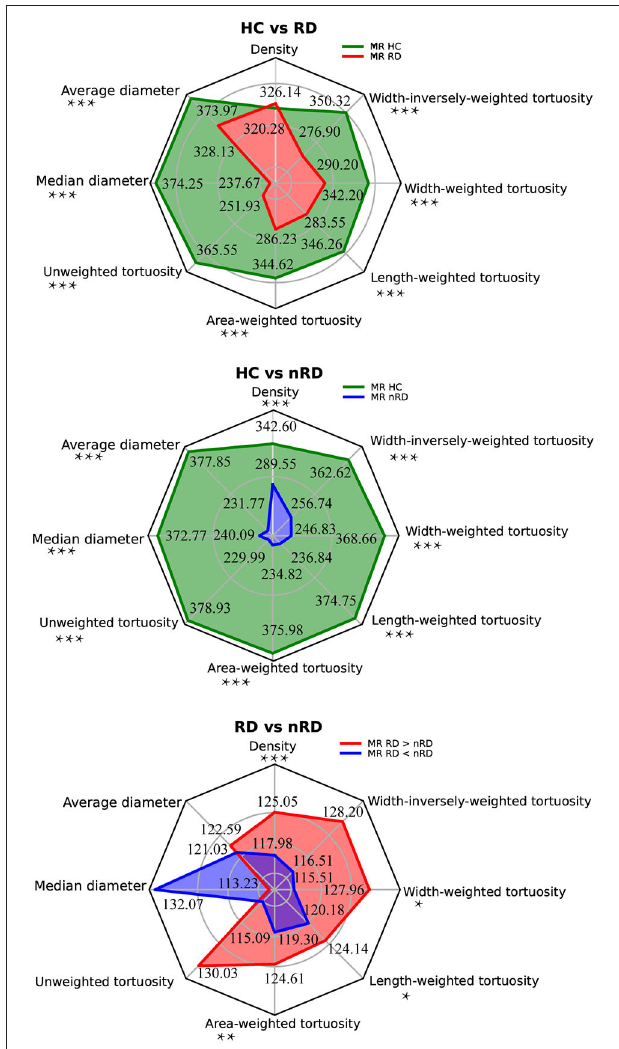
FIGURE 3 | Group comparisons among HC, RRD, and non-RRD groups of all vascular parameters. The three radar plots displayed all vascular parameters from the top with anti-clockwise order, they are density, average diameter, and median diameter to evaluate vascular caliber; unweighted tortuosity, area-weighted tortuosity, length-weighted tortuosity, width-weighted tortuosity, and width-inversely-weighted tortuosity to measure vascular tortuosity. The top panel represented mean rank results from the comparison between HC and RRD groups by the Mann-Whitney test, HC in green and RRD in red. The middle panel showed mean rank results between HC and non-RRD groups by the Mann-Whitney test, HC in green and non-RRD in blue. The bottom panel illustrated results from the Wilcoxon signed-rank 2-tail test between RRD and non-RRD comparison, whereas ranks which RRD larger than non-RRD in red and ranks which RRD smaller than non-RRD in blue. In all three comparisons, n HC = 400, non-RRD = 244, and n non − RRD = 244. * p < 0.05, ** p < 0.01, *** p < 0.001. HC, healthy controls; RRD, rhegmatogenous retinal detachment.